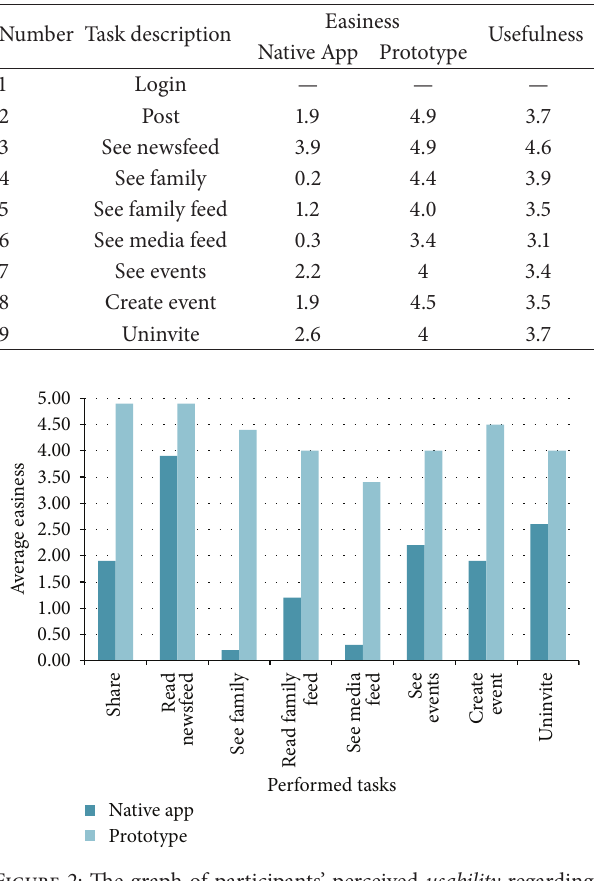
Figure 2: The graph of participants’ perceived usability regarding the user studies’